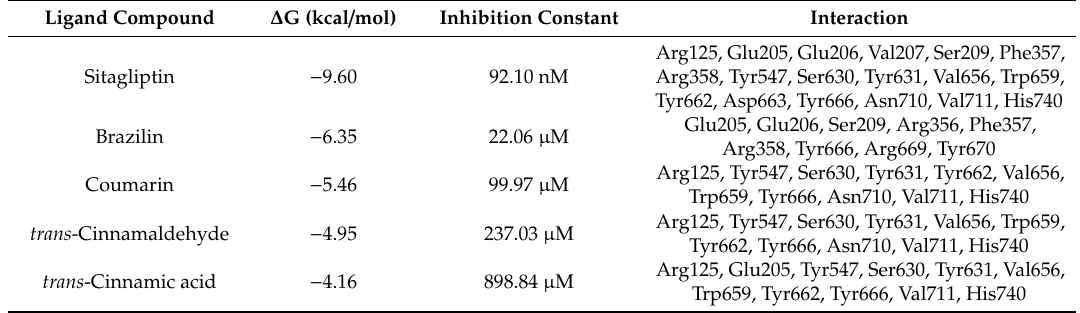
Table 2. The docking results of sitagliptin and marker compounds from cinnamon bark and sappan wood.